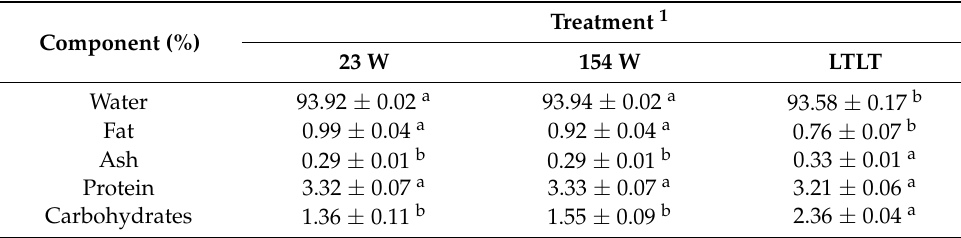
Table 2. Effect of ultrasound power and pasteurization on proximal composition of whey–oat beverages. Component